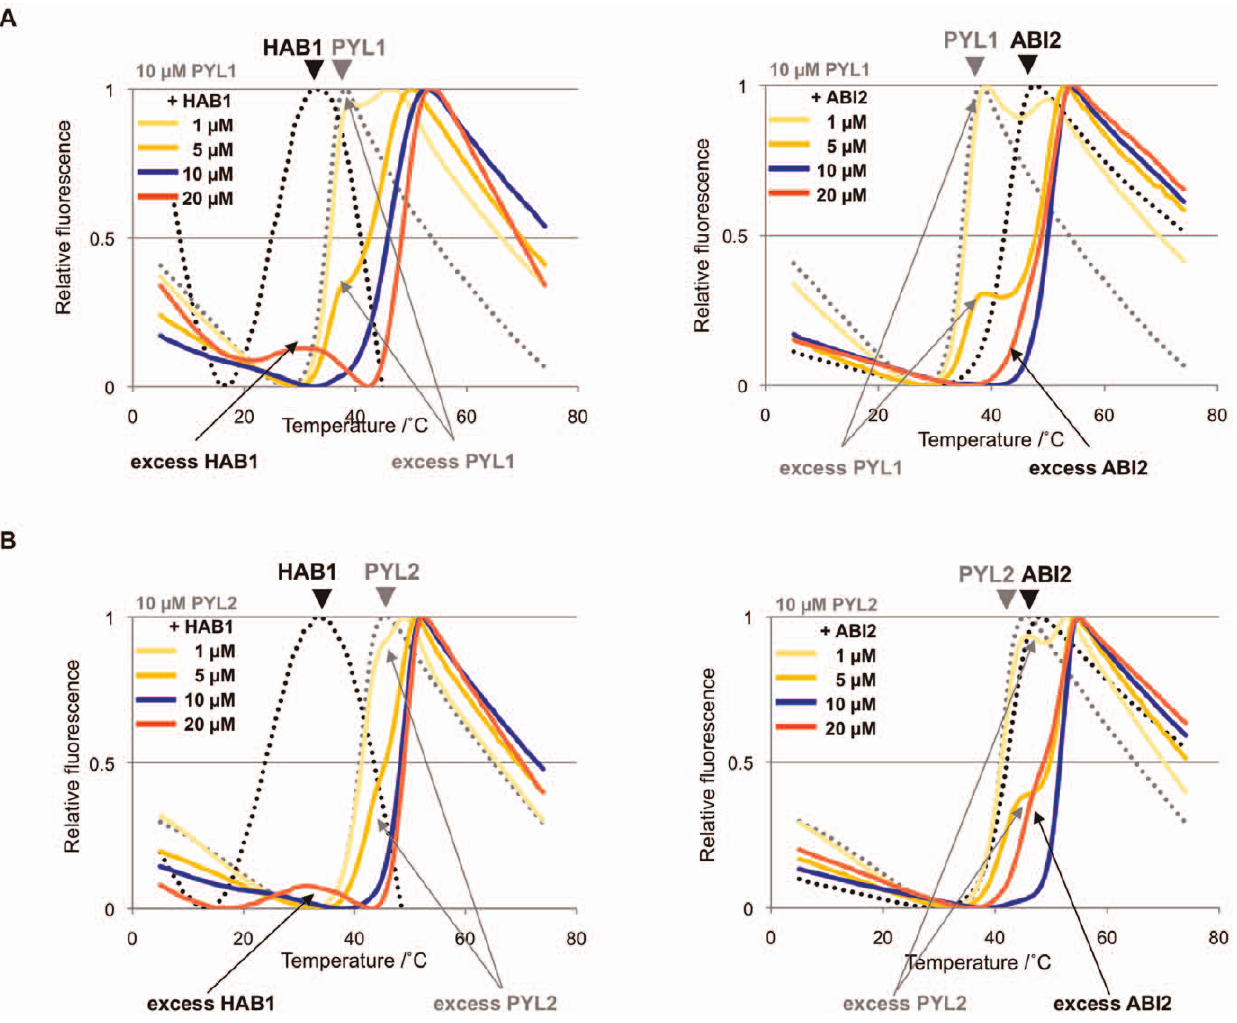
Figure 7. Stoichiometry of receptor/ligand-phosphatase complexes. Transition curves of ABA-bound PYL1 and PYL2 in the presence of increasing amounts of HAB1 and ABI1 PP2Cs. The melt curves for receptors in the absence of PP2Cs (dashed grey lines ) and PP2Cs in the absence of receptors (dashed black lines ) are shown as references. The positions of uncomplexed, excess receptors and PP2Cs are indicated by arrows. Each panel shows titrations of 10 m M receptor with PP2Cs at 1 m M (pale yellow line), 5 m M (yellow line), 10 m M (blue line) and 20 m M (orange line) PP2C. ( A ) PYL1/ABA titrated with HAB1 (left) and ABI2 (right). ( B ) PYL2 titrated with HAB1 (left) and ABI1 (right).